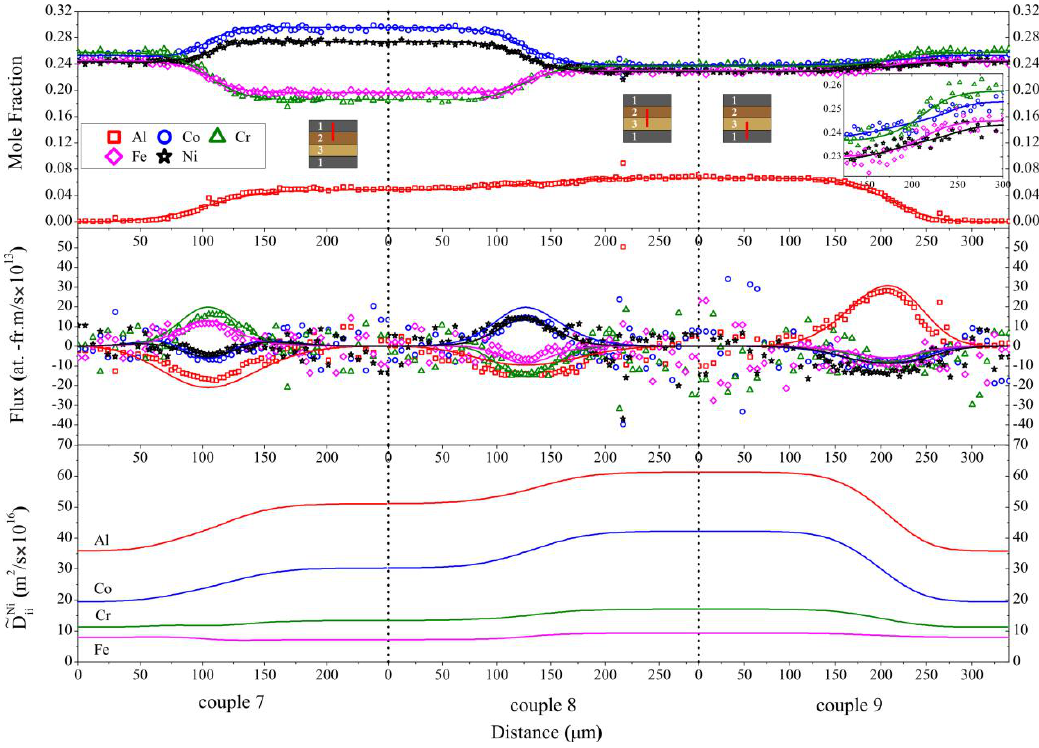
Figure 3. Comparison between the experimental and the simulated concentration profiles/interdiffusion fluxes of diffusion couples annealed at 1323 K for 46 h as well as the evaluated diagonal interdiffusivities. Symbols are due to the experimental measurements.